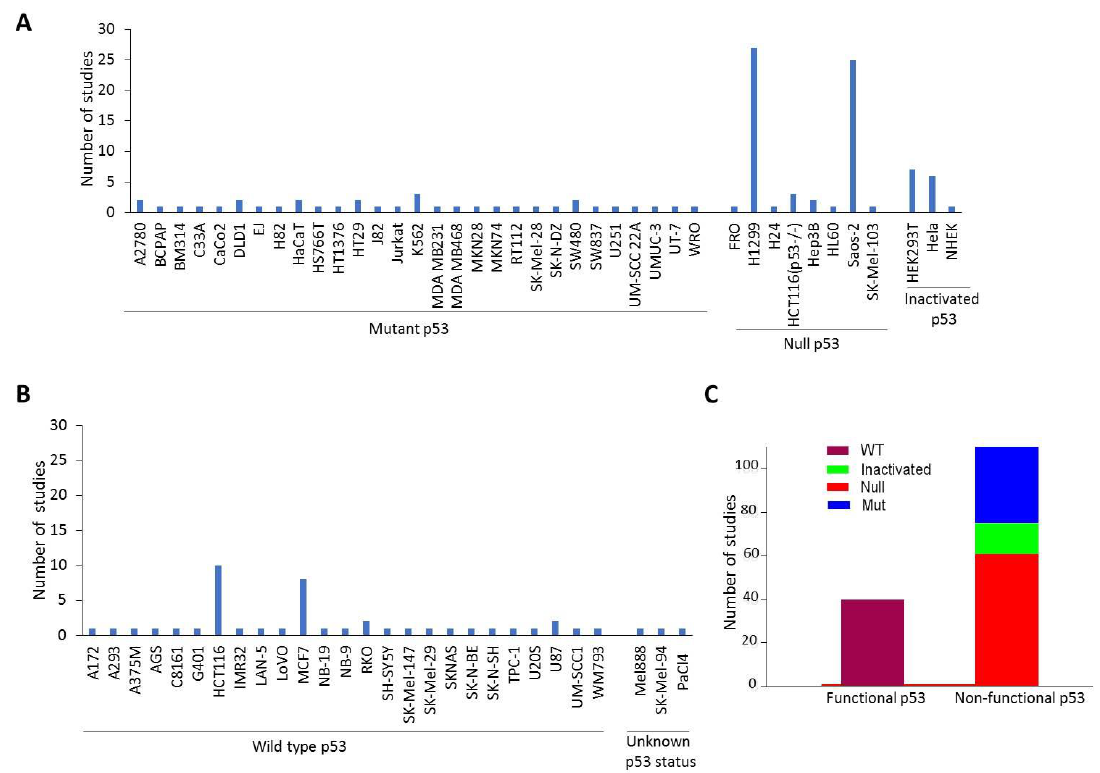
Figure 2. Cell lines used in identification of TAp73 targets. The frequency of cancer cell lines used in the 71 focused studies for identifying TAp73 target genes is depicted. ( A ) Cell lines with non-functional p53 and ( B ) cell lines with functional p53 or of unknown p53 status. ( C ) The number of studies using the various cell lines based on their p53 status is depicted. Please note that some studies used multiple cell lines.